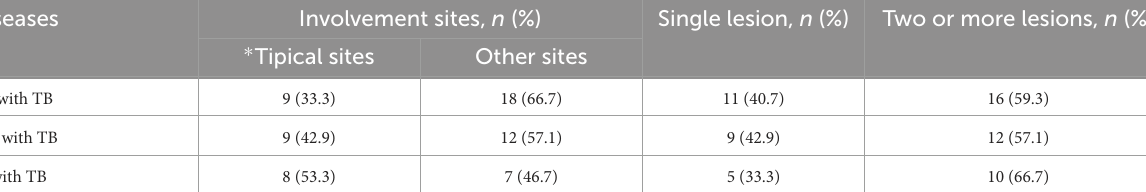
TABLE 4 Chest CT manifestations of pulmonary TB in TB